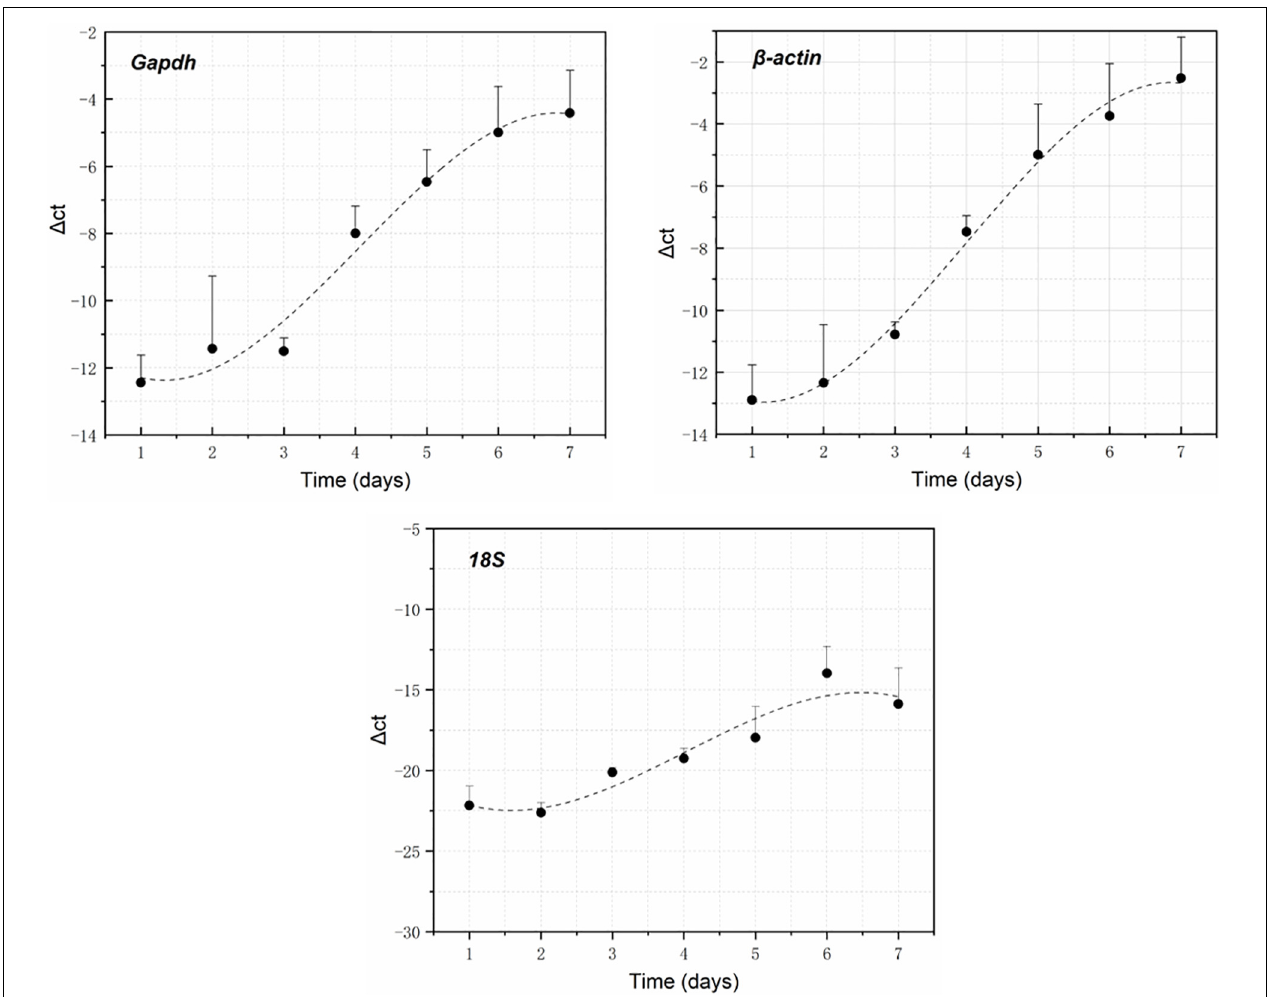
FIGURE 2 | GAPDH, β -actin, and 18S expression changes within 7 days after death using 5S as the reference gene.